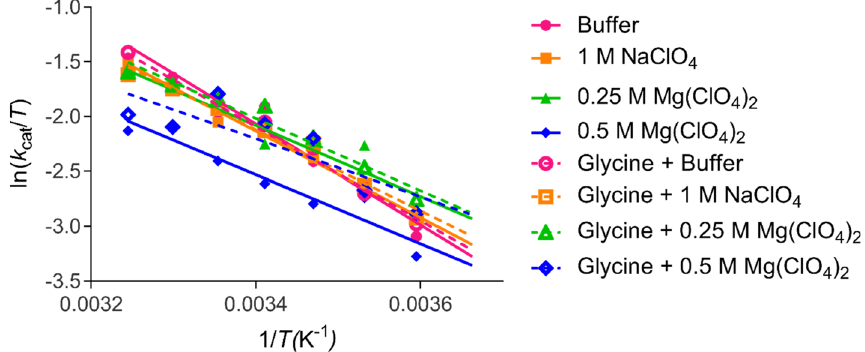
Figure 1. Eyring plot of α-chymotrypsin activity. The activity of α-chymotrypsin in all conditions assayed from 308 K (35 °C) to 278 K (5 °C) (left to right) with their corresponding linear regressions extrapolated from 308 to 273